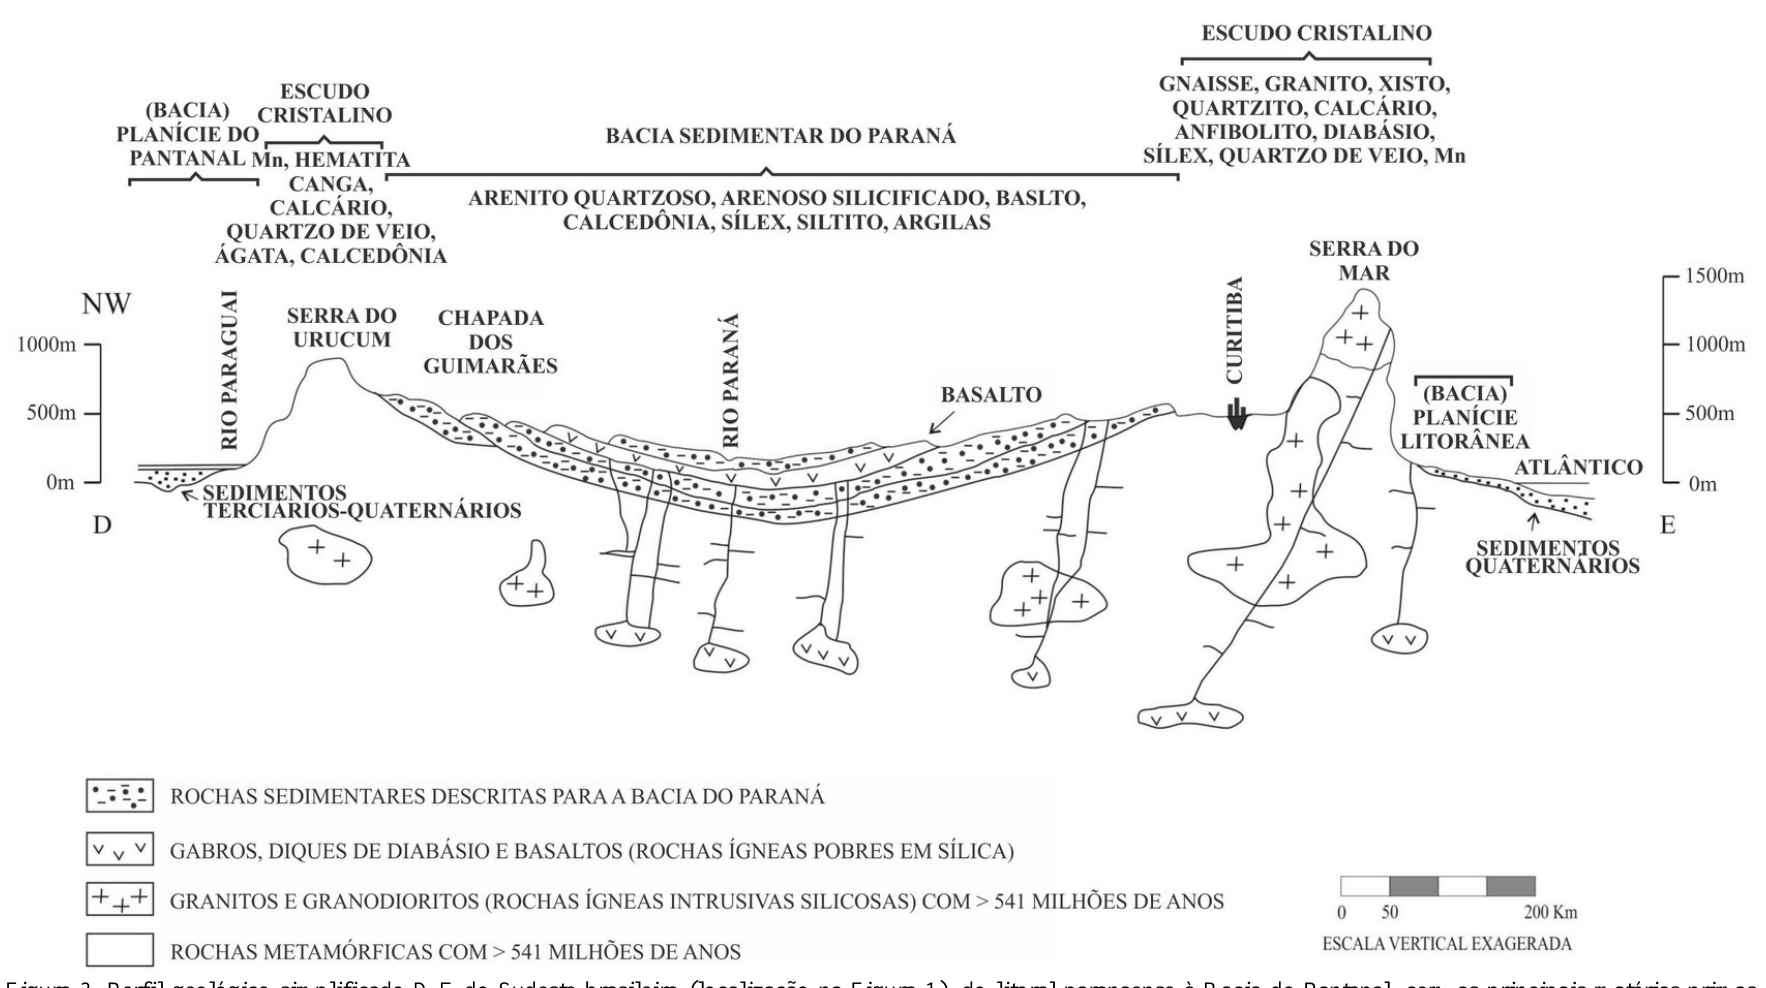
Figura 3. Perfil geológico simplificado D-E do Sudeste brasileiro (localização na Figura 1), do litoral paranaense à Bacia do Pantanal, com as principais matérias-primas disponíveis. Fonte principal: Hasui et al. (2012). Figure 3. Geological simplified D-E profile (localization in the Figure 1), from the Coast of Parana State to the Pantanal Basin, with the main available lithic raw-materiais. Main source: Hasui et al.